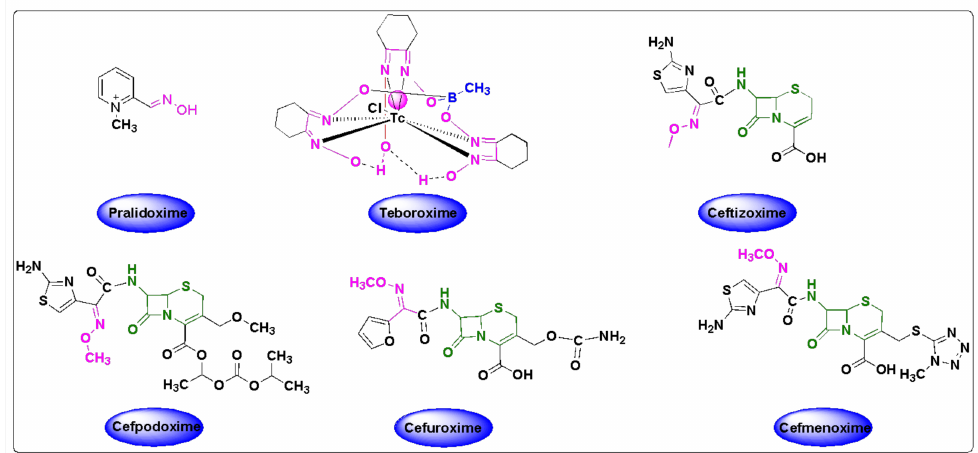
Figure 2. Chemical structures of FDA-approved